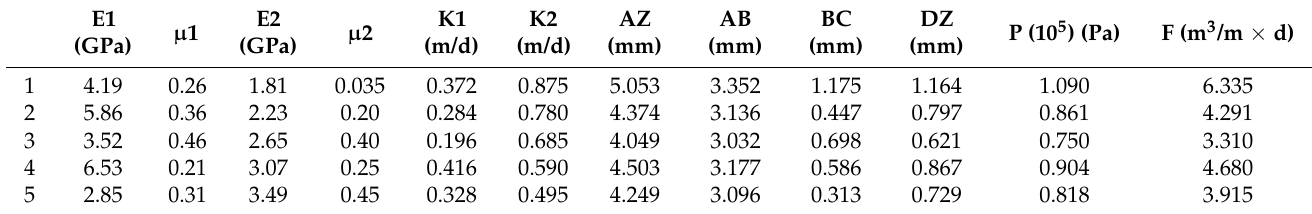
Table 3. Uniform parameter test methods and the results of numerical